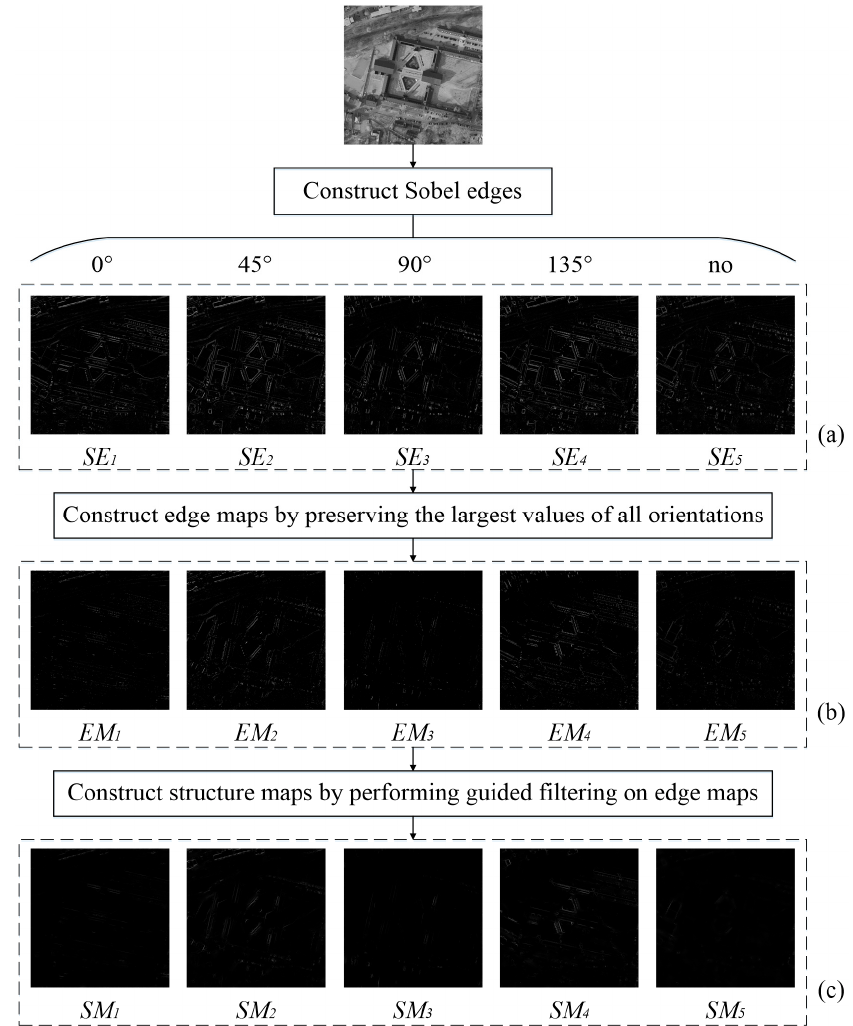
Figure 4. Illustration of oriented structure maps construction. From top to bottom: ( a ) Sobel edges SE n , ( b ) edge maps EM n , and ( c ) structure maps SM n